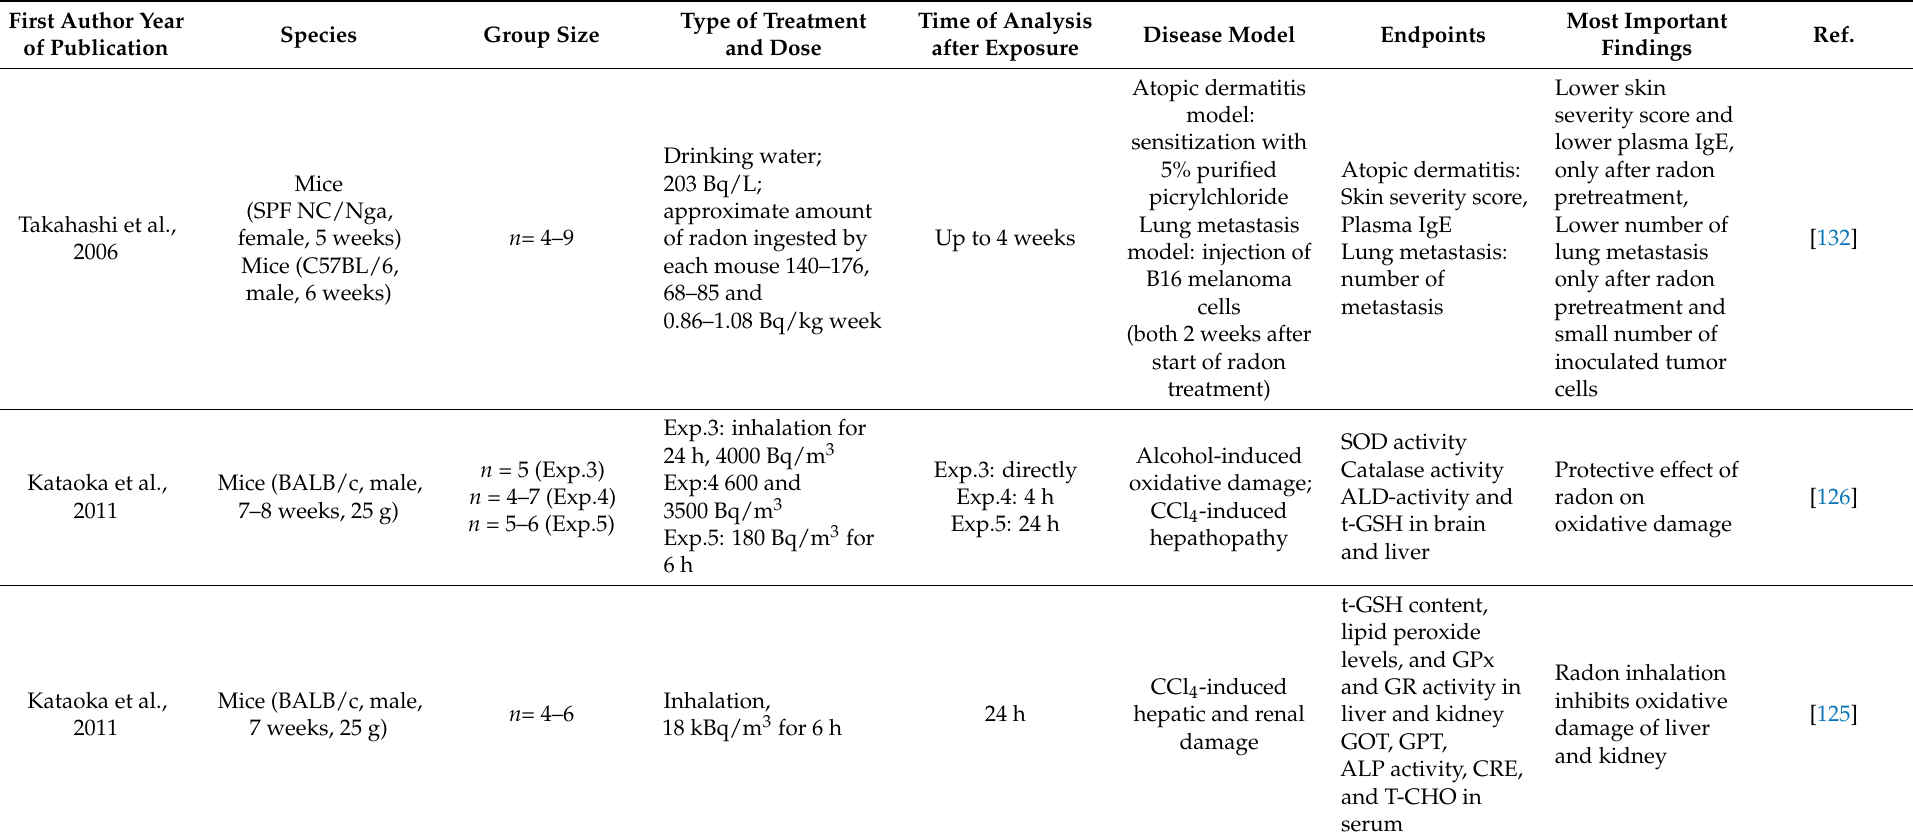
Table 4. Animal studies with